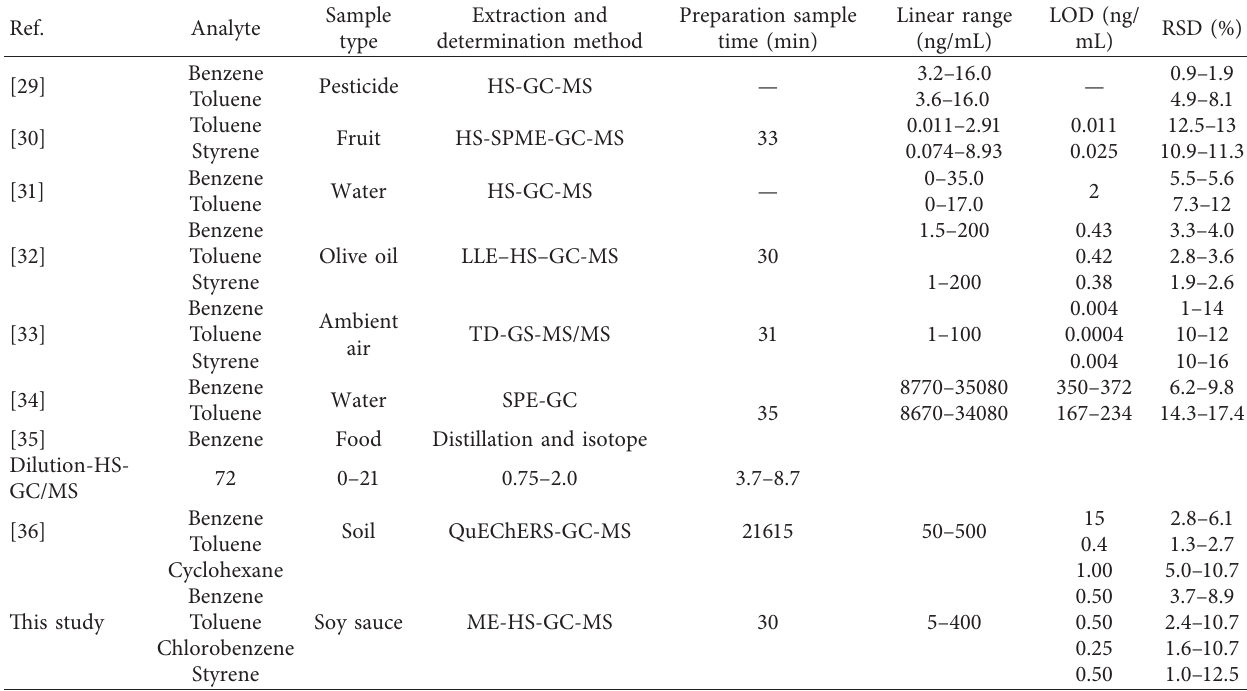
Table 4: Comparison of the method proposed with the method developed earlier in the analysis of volatiles.